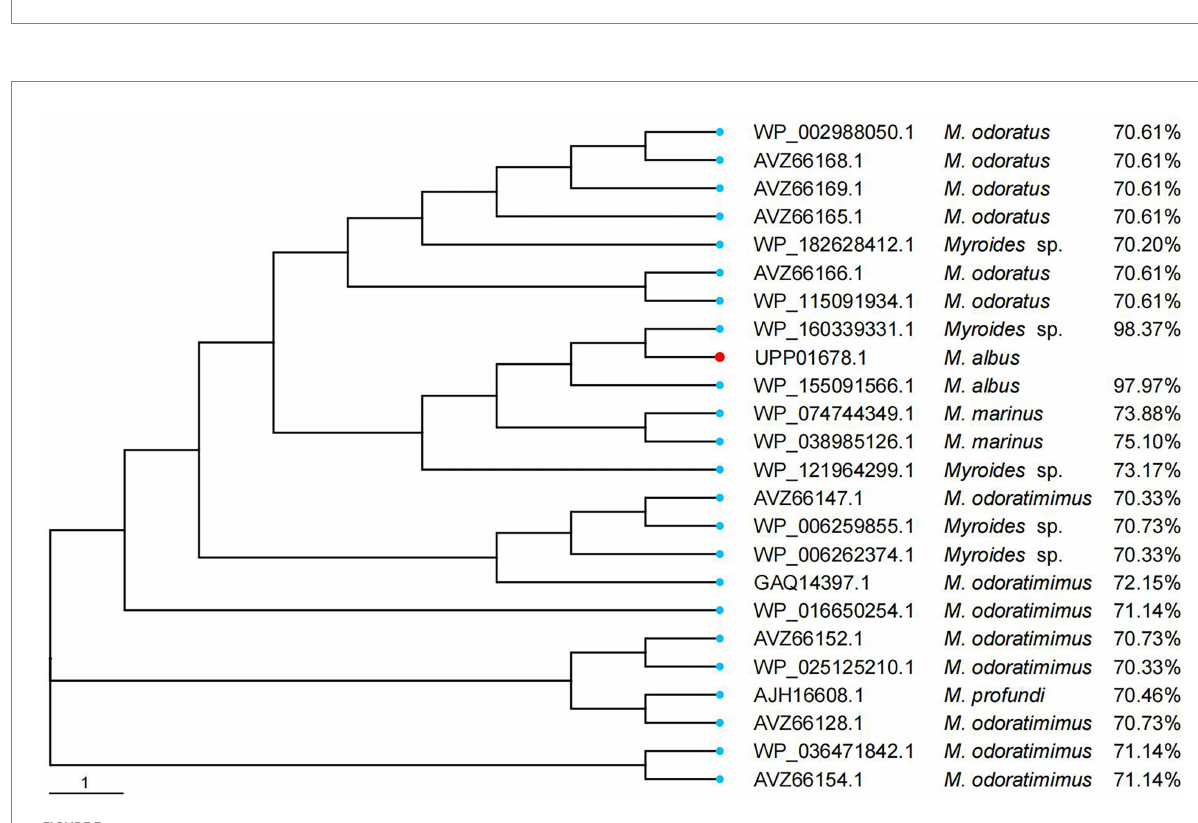
FIGURE 2 Amino acid alignment of WUS-1 with other function-characterized class B β -lactamases. Dots indicate amino acid residues identical to those of WUS-1. Amino acid residues that may be involved in Zn2+ binding are shaded in black. The predicted signal sequence cleavage site for WUS-1 is indicated by a black arrow. The sequences and their accession numbers are as follows: MUS-1 (AAN63647.1), TUS-1 (AAN63648.1), MUS-2 (AKN19901.1), and JOHN-1 (AAK38324.1).